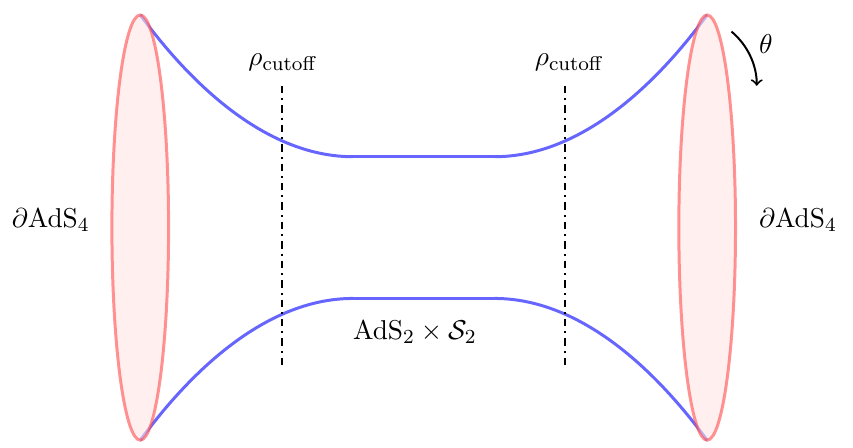
Figure 2 . Wormhole geometry: in the throat region the metric has the AdS 2 ×S 2 form (3.12) up to the cutoff located at ρ ∼ L/ ¯ r . Around this point, where the limits (3.23) are satisfied, the geometry smoothly interpolates to near-extremal Reissner-Nordström black holes in AdS 4